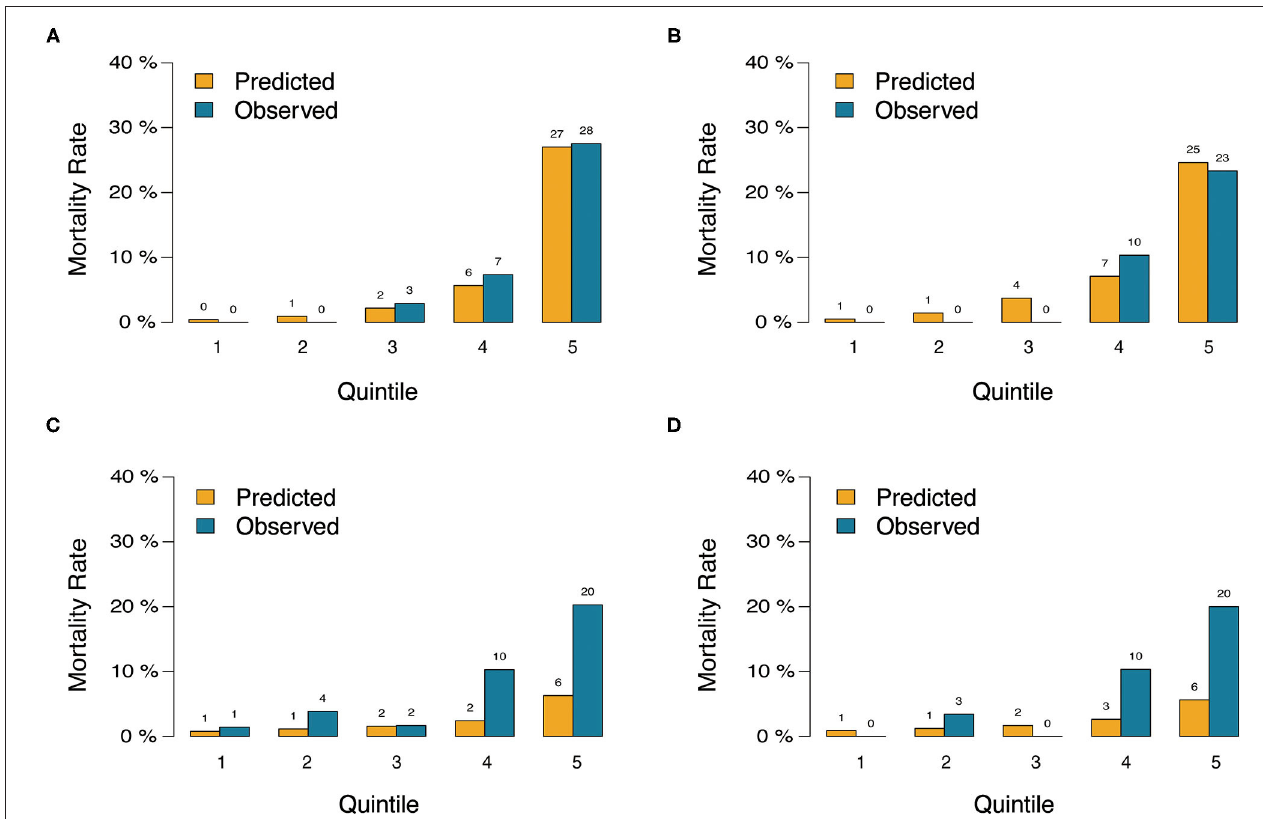
FIGURE 4 | Predicted vs. observed risk of death after CABG based on quintile of predicted risk in training cohort and validation cohort. (A) the nomogram in training cohort. (B) The nomogram in validation cohort. (C) The EuroSCORE-2 in training cohort. (D) The EuroSCORE-2 in validation cohort.